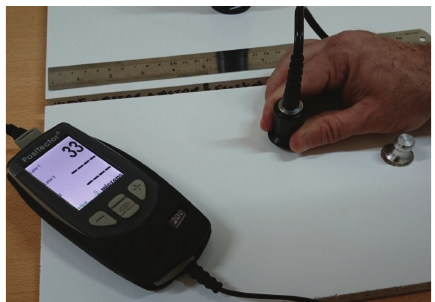
Figure 2: Coating thickness measurement